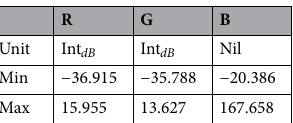
Table 5. Statistical summary of σ